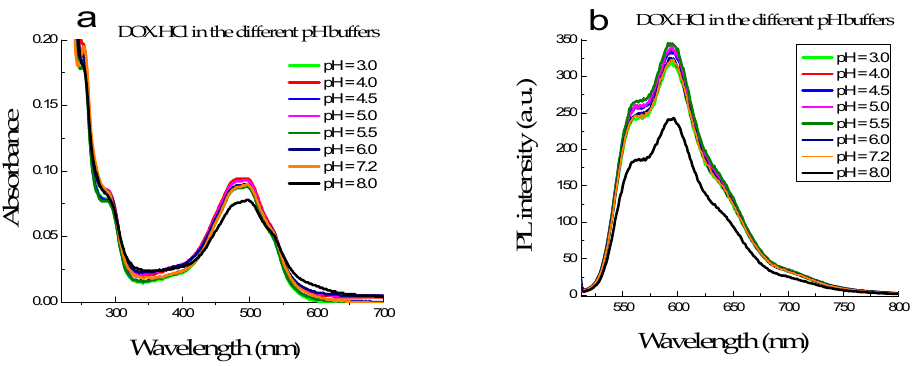
Figure 2. The absorption ( a ) and fluorescence ( b ) spectra of DOX·HCl in varying pH buffer solution from 3.0 to 8.0.